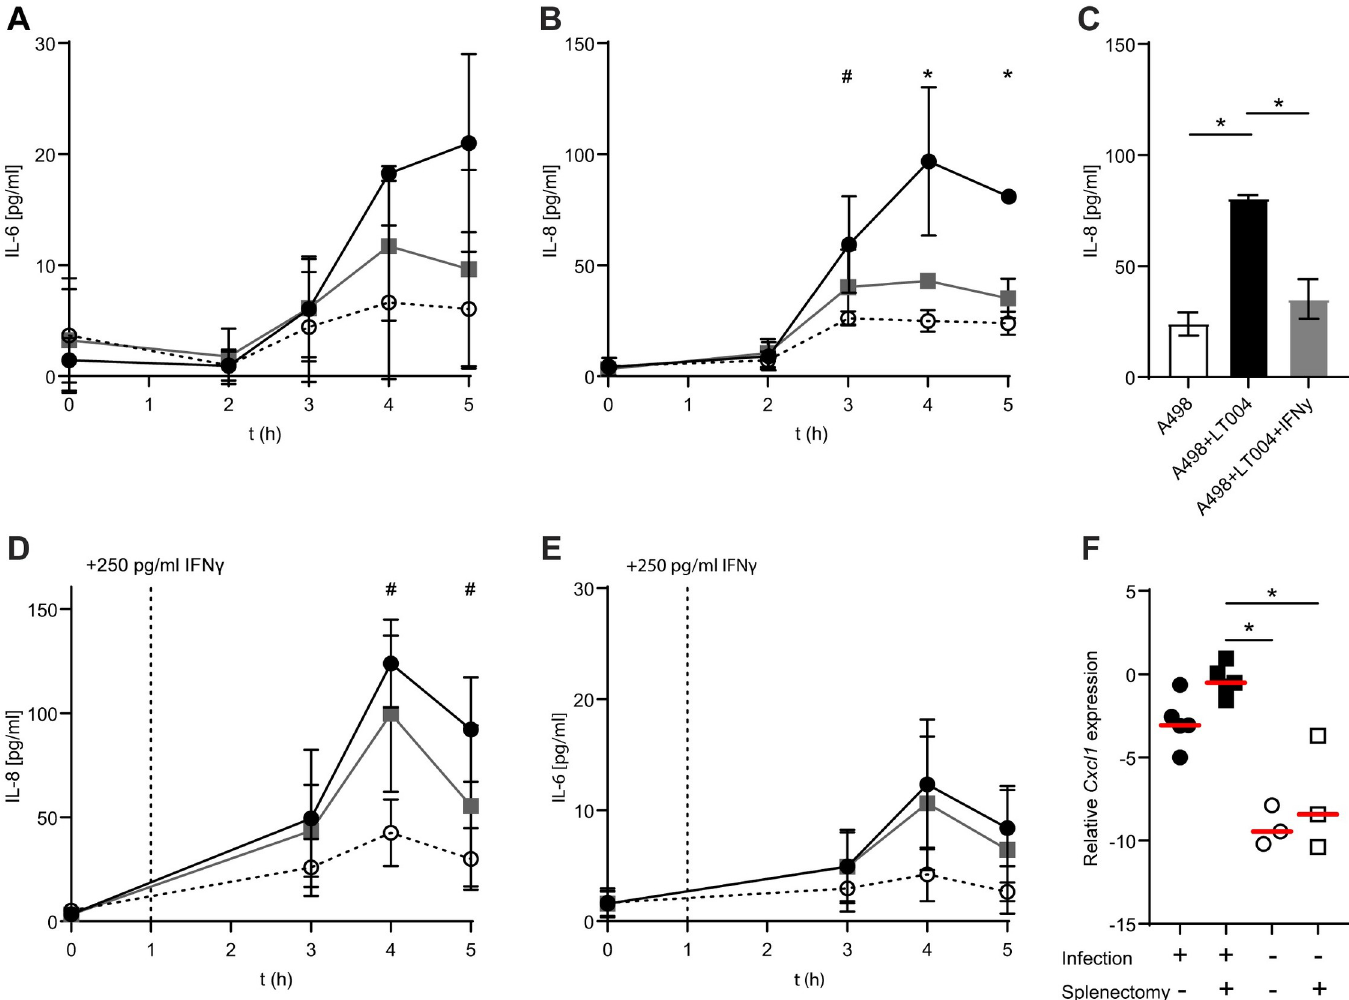
Fig 4. IFN γ dampens proinflammatory signalling from infected kidney cells. ( A-B ) ELISA measurements of ( A ) IL-6 and ( B ) IL-8 release over time from renal epithelial A498 cells under flow, infected with LT004 (black circles), no infection (unfilled circles) or infection with addition of 250 pg/ml IFN γ (grey boxes), n = 3. The IL- 8 data from the 5 h timepoint is re-visualized in ( C ) to show statistical significance. ELISA measurement of ( D ) IL-8 and ( E ) IL-6 release over time from A498 cells infected with LT004 under flow (black circles), uninfected (unfilled circles) or infected with the addition of 250 pg/ml IFN γ 1 h post infection (grey boxes), n = 4. Graphs in A-E show means ± SD. Significance was calculated by two-way ANOVA, with Turkey’s correction for multiple comparisons. � = p < 0.05 with significance for comparison between uninfected and both LT004 infected and LT004 infected cells co-incubated with 250 pg/ml IFN γ . # = p < 0.05 with significance for comparison between uninfected and LT004 infected cells. ( F ) Cxcl1 mRNA expression in sham-splenectomised (circles) or splenectomised (squares) animals, either infected (black symbols) or PBS- infused (unfilled symbols). Gene expression is given in relation to the reference gene Gapdh (delta CT). Individual data points and median (red bar) are shown. n = 3–5 in each group. � = p < 0.05 calculated by Kruskal-Wallis analysis and Dunn’s correction.